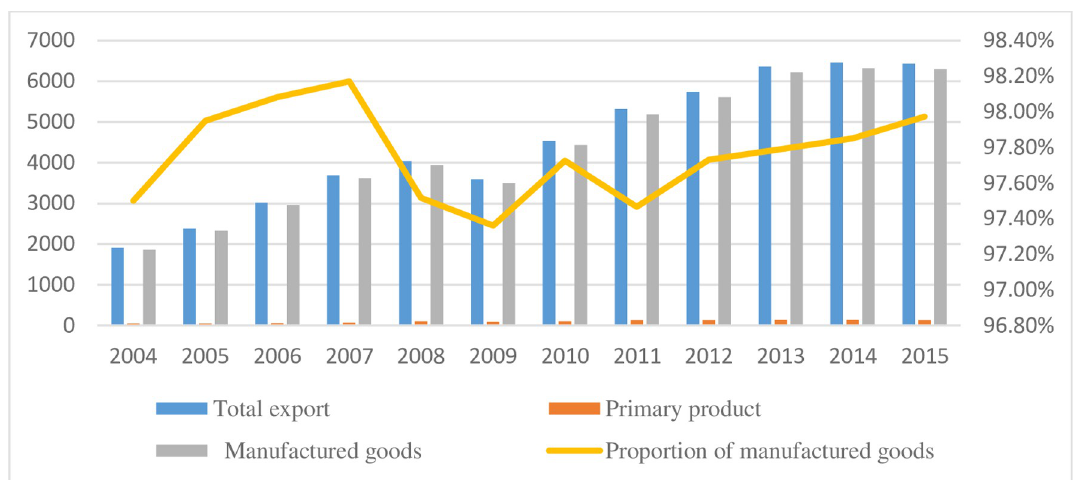
Fig 1. The structure of exports in Guangdong Province (unit: USD 100